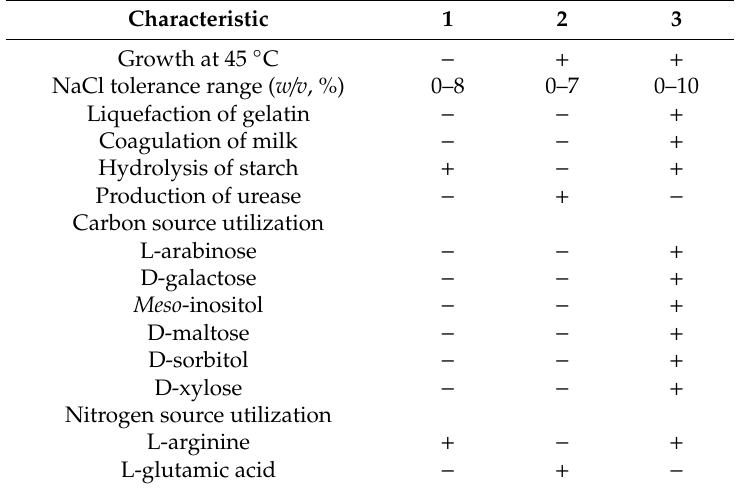
Table 1. Di ff erential characteristics of strain LD120 T and its closely related strains. Characteristic 1 2 3 Growth at 45 ◦ C − + + NaCl tolerance range ( w / v , %) 0–8 0–7 0–10 Liquefaction of gelatin − − + Coagulation of milk − Hydrolysis of starch Production of urease Carbon source utilization L-arabinose D-galactose D-maltose D-sorbitol Nitrogen source utilization L-arginine